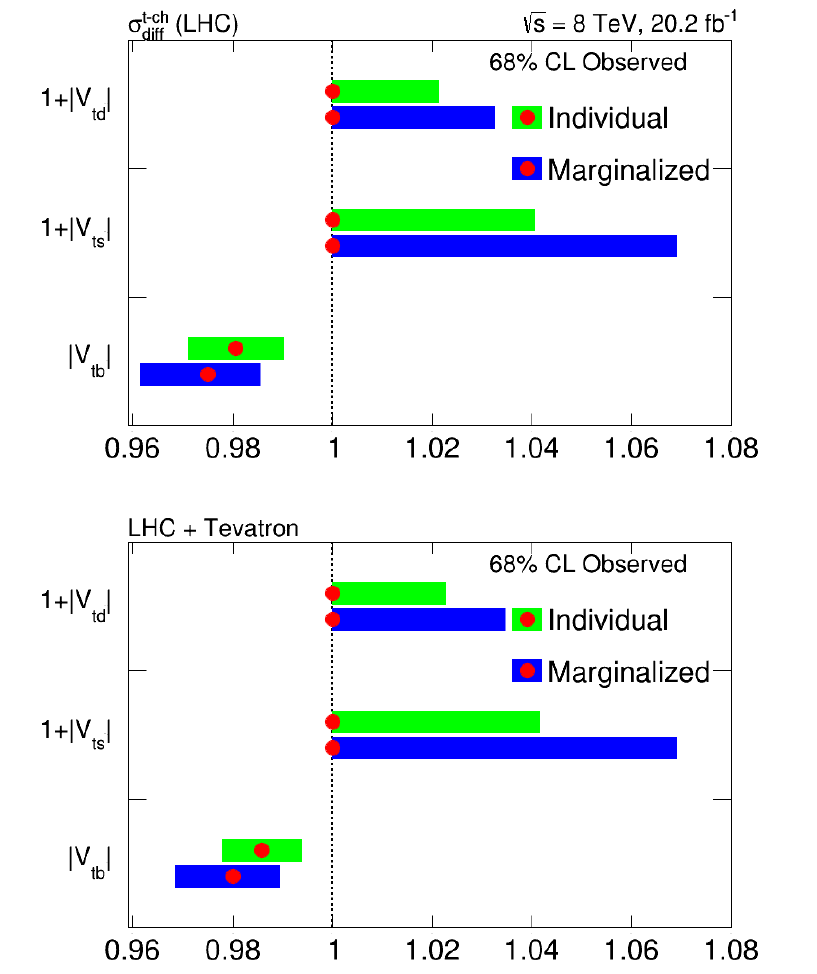
Figure 7 . Observed individual and marginalized best (cid:12)t values together with 68% con(cid:12)dence interval for the j V td j , j V ts j and j V tb j CKM elements obtained from single top t -channel di(cid:11)erential cross section measurements at 8 TeV (top) and from the combination of all LHC and Tevatron measurements (bottom).